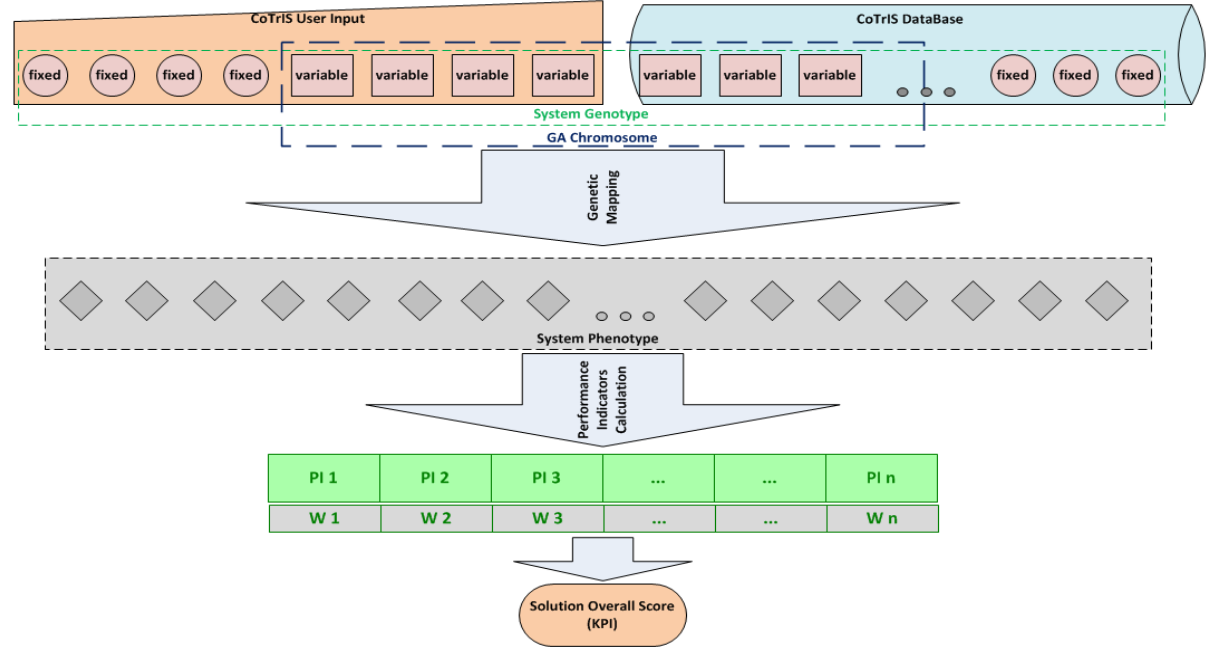
Figure 9. GA Chromosome (Genotype – Phenotype) & Overall